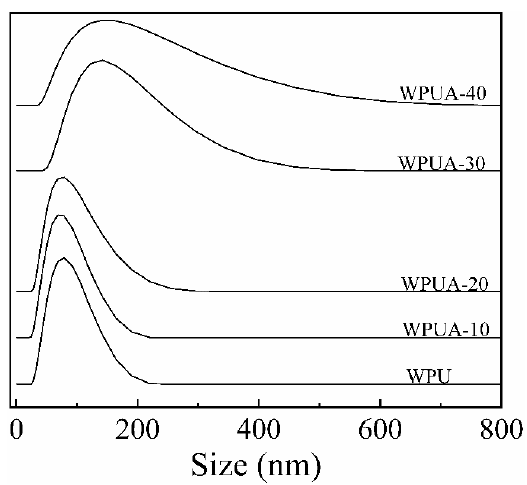
Figure 2. Thermogravimetric curves of WPU, WPUA-10, WPUA-20, WPUA-30, and WPUA-40 coatings.